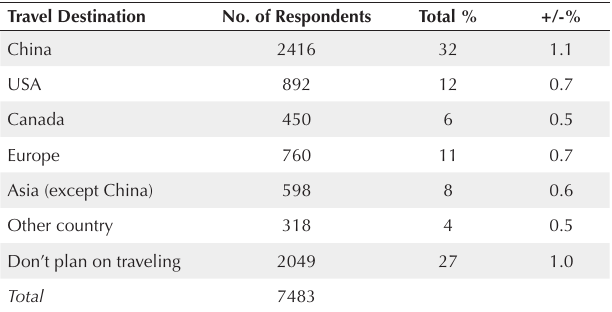
Table 1. Where Do You Plan to Travel Next for Vacation?